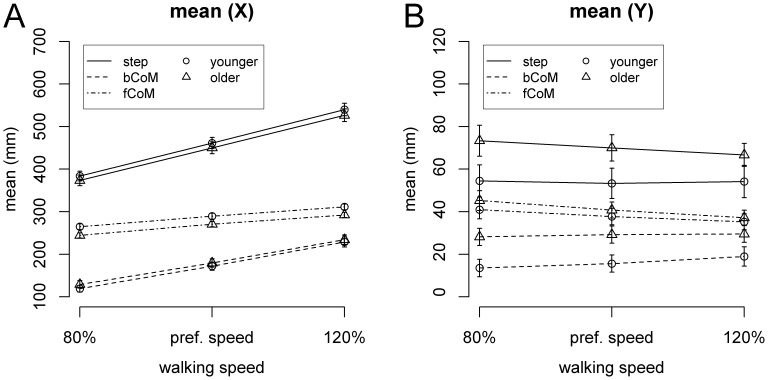
Mean of task variables in fore-aft (A) and lateral (B) direction as a function of walking speed and age group.Error bars represent SEM.